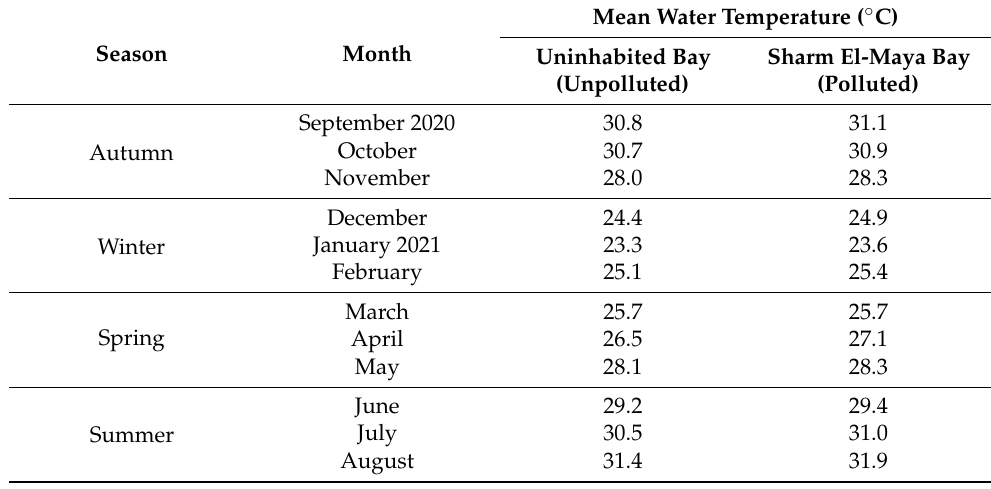
Table 1. Monthly water temperature ( ◦ C) in the uninhabited bay and in the Sharm El-Maya Bay.